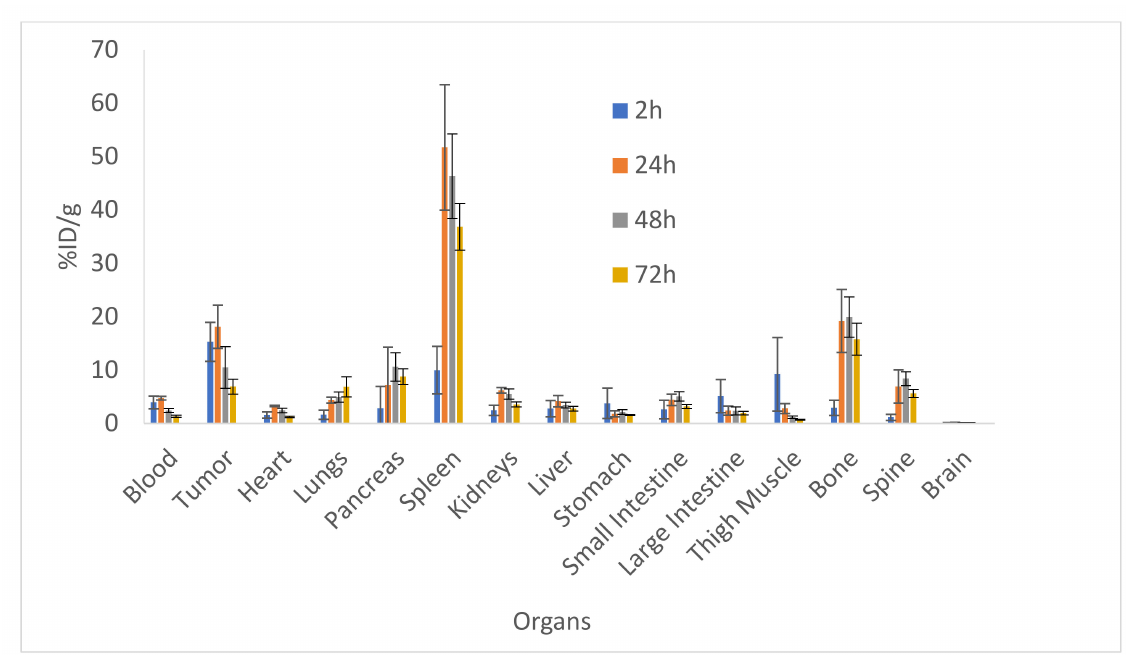
Figure 1. Biodistribution of 111 In-IF3 mAb to IGF2R in female SCID mice bearing canine-patient- derived Gracie tumors after IP administration at 2, 24, 48 and 72 h post-administration.